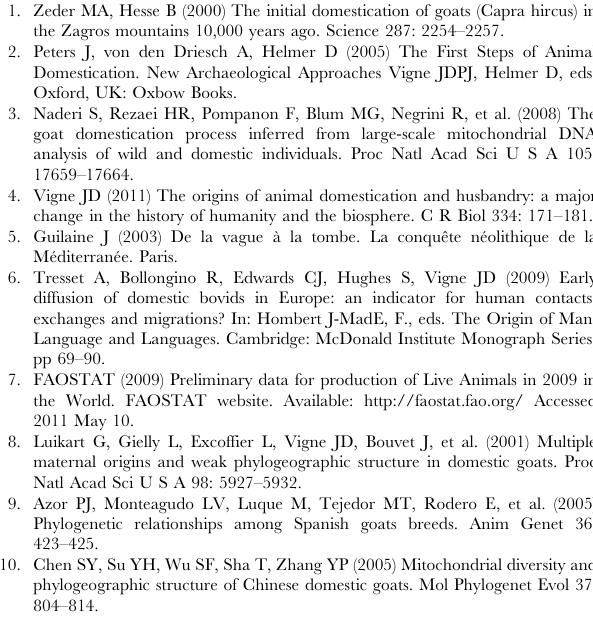
Figure S4 Mismatch distributions for medieval and extant Corsican goat populations. The numbers of pairwise differences are given on the x-axis and their frequency on the y- axis. Table S1 Corsican goats sampling and mitochondrial genotyping results. A star indicates archeological samples for which the molecular identification was Ovis aries and a dash when no amplification was obtained. Table S2 Population pairwise F ST . Pairwise difference was used as distance method. F ST values are given at upper right corner and corresponding p-values at bottom left. Significant p-values are highlighted in color (orange for intra-Corsica comparisons, pink for inter comparisons). NS: Non-significant, * p-value between 0.05 and 0.01, ** p-value between 0.01 and 0.001, *** p-value , to 0.001. Table S3 Genetic diversity parameters. Comparison for A and C haplogroups between Corsican and other Mediterranean or Portuguese datasets (see Figures S1, S3 and